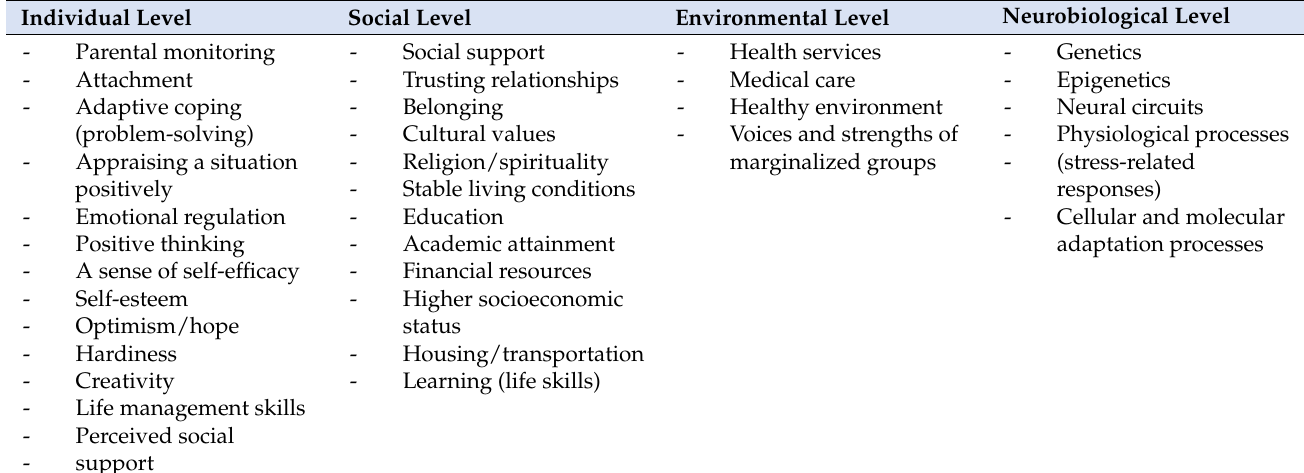
Table 1. Factors and mechanisms of resilience across the